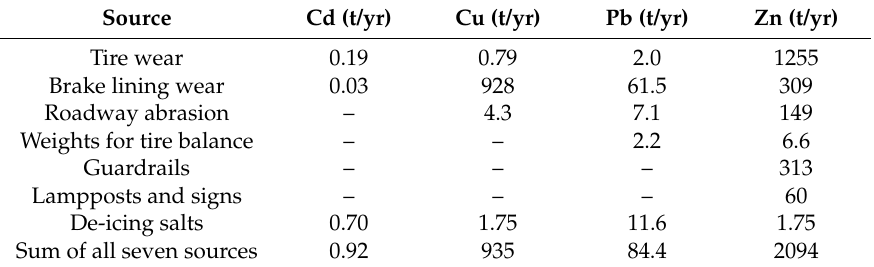
Table 7. Traffic related heavy metal emissions in Germany (summary of mean values of the calculations presented in Section 3.4.2 that are based on different literature